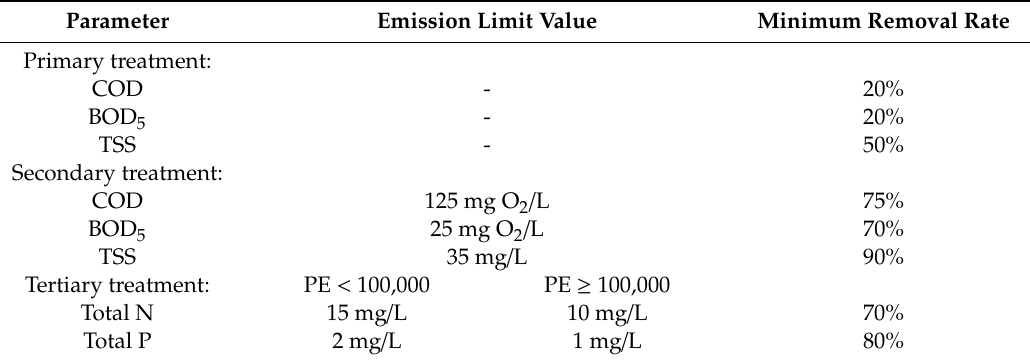
Table 2. Minimum pollutant removal rates for WWTPs in